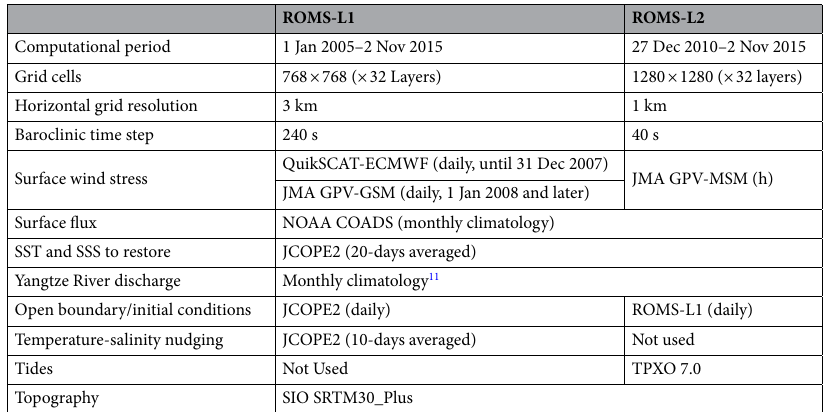
Table 1. Model parameters for ROMS-L1 and ROMS-L2 setting conditions 4 .